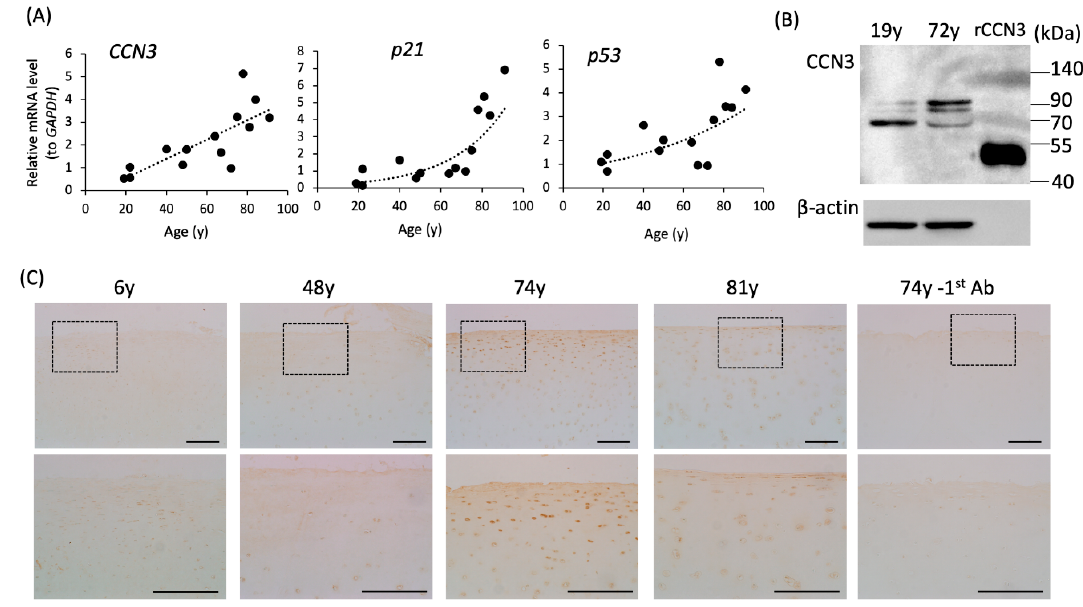
Figure 6. Elevated expression of Ccn3 , p53 , and p21 mRNA in aged human articular cartilage. ( A ) Comparison of mRNA expression levels of CCN3 , p53 , and p21 in the primary culture of human articular chondrocytes at different ages. The expression level of Ccn3 , p53 , and p21 mRNA was standardized to Gapdh. From one patient, articular cartilage was collected and digested, and cultured in multiple dishes. Total RNA was collected at least 3 dishes individually, and real time-PCR was performed in triplicates for each RNA sample; one ‘dot’ indicates average of gene expression level from one patient. (positive correlation, all p < 0.01). ( B ) Western blot analysis of CCN3 protein in primary culture of the articular chondrocytes (8 µg protein/lane) from different ages (y) as indicated. ( C ) Immunohistochemical staining of CCN3 in human articular cartilage (tibiae) of several ages. Top: lower magnification; bottom: higher magnification of the black square in the top. Scale bar: 200 µm.